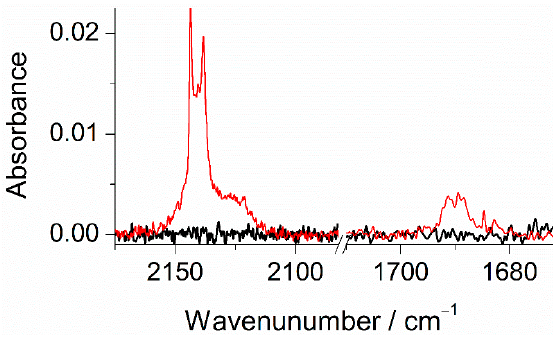
Figure 6. Selected regions of the experimental spectra of m FP (Ar, 16 K) recorded after 2 min of UV-irradiation at λ = 270 nm (red trace) and before any UV-irradiation (black trace). A band with maxima at 2144/2138 cm − 1 is also observed in the spectra recorded for